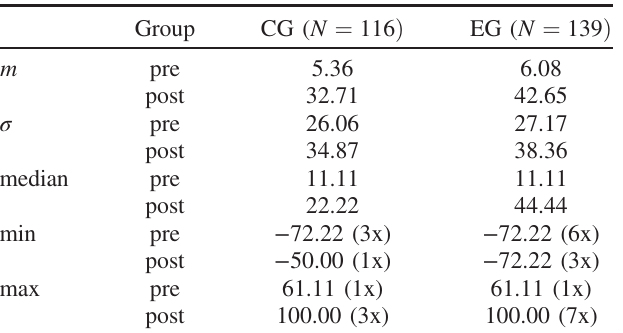
TABLE IV. Descriptive statistics on the conception indices for the quantum objects ’ properties and behavior in control and experimental groups at both survey time points (pre and post). The number of students who achieved the respective minimum and maximum scores for both CG and EG are noted in parentheses.